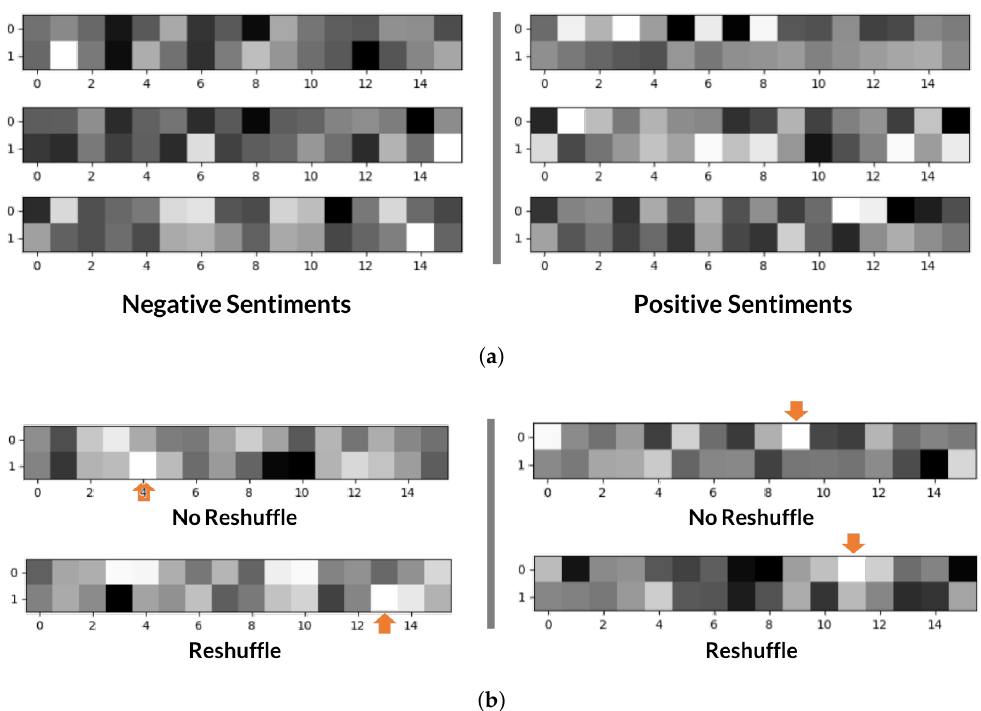
Figure 6. Visualization of the Class Caps Layer. ( a ) class identification based on longest capsule in Class Caps Layer; ( b ) output of Class Caps Layer before and after shuffling (left: negative sentiment, right: positive